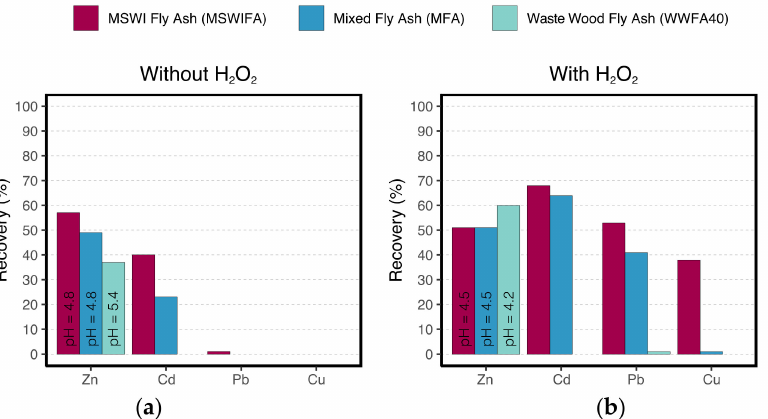
Figure 2. Heavy metal recovery in % for the target heavy metals Zn, Cd, Pb, Cu for the 3 different ash types in laboratory experiments. The pH of the leachate is indicated in the bar for Zn